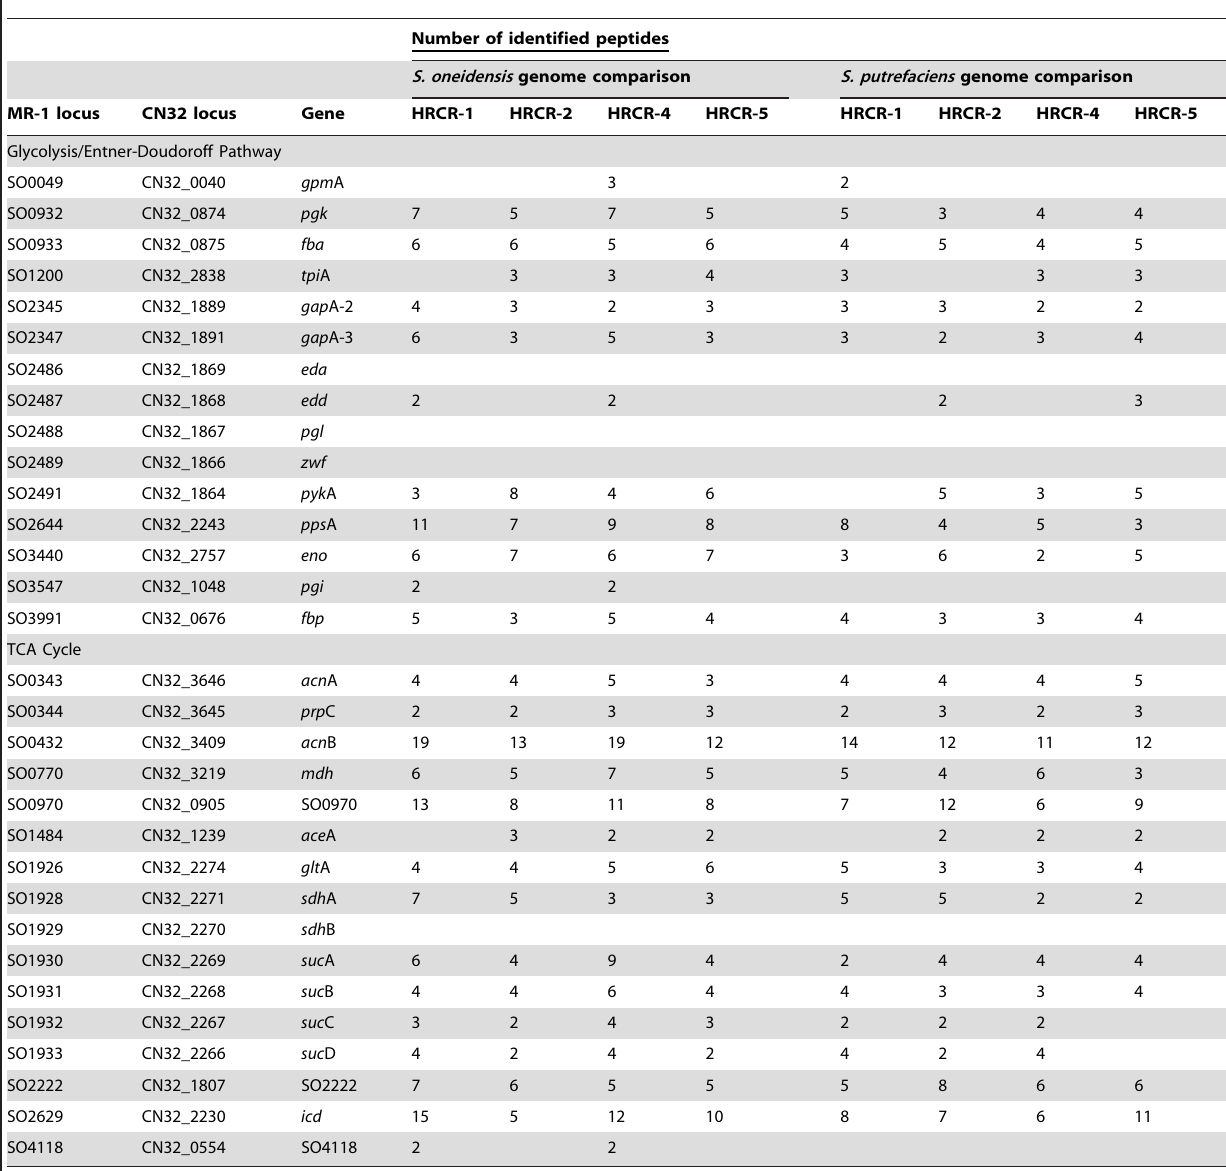
Table 4. Shewanella isolates were identified from the Columbia River, based on 16S rDNA